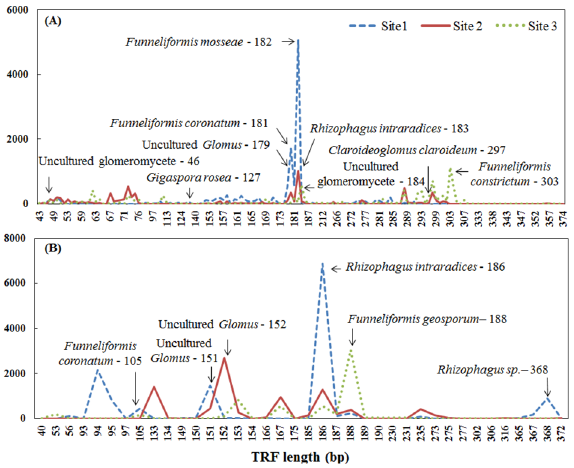
Fig 2. Peak abundance of Terminal Restriction Fragments (T-RFs) and AMF ribotype corresponds to fragment size. (A) Alu I, (B) Mbo I